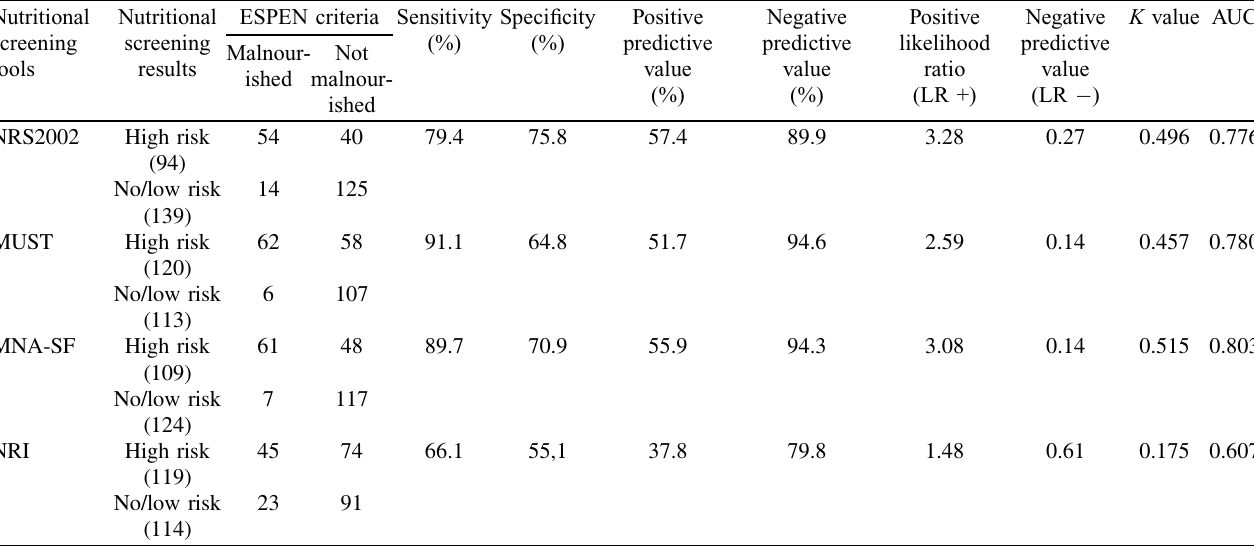
Table 5. Comparison of four screening tools for malnutrition with ESPEN diagnostic criteria in cystic echinococcosis patients. Nutritional Nutritional screening tools